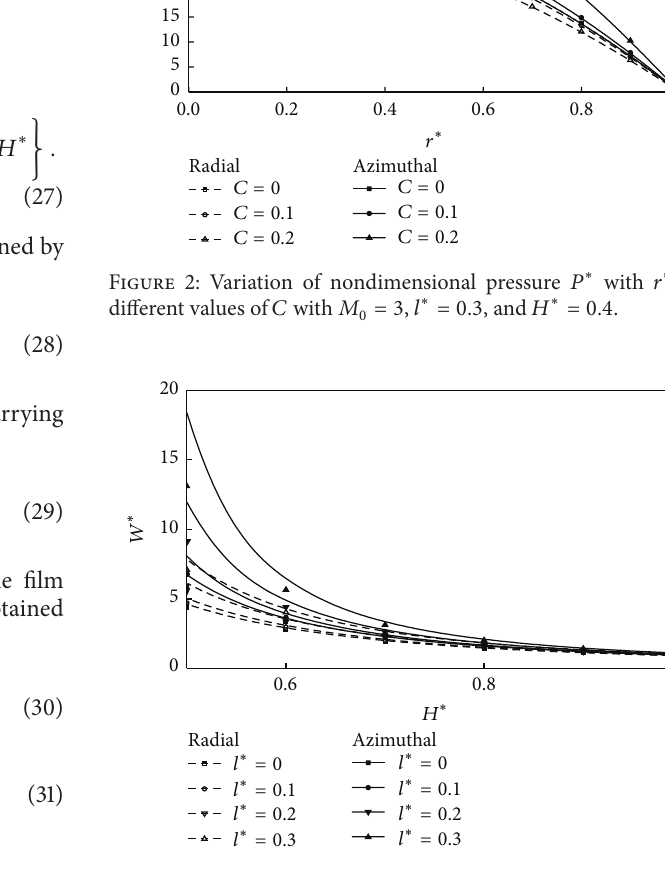
Figure 3: Variation of nondimensional load carrying capacity 𝑊 ∗ with 𝐻 ∗ for different values of 𝑙 ∗ with 𝑀 0 = 3 and 𝐶 = 0.3